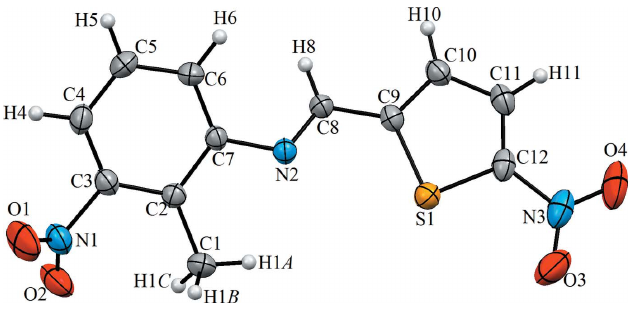
Figure 2 A view of the crystal packing of the title compound parallel to the bc plane. C—H (cid:3)(cid:3)(cid:3) O interactions are indicated by dotted lines.